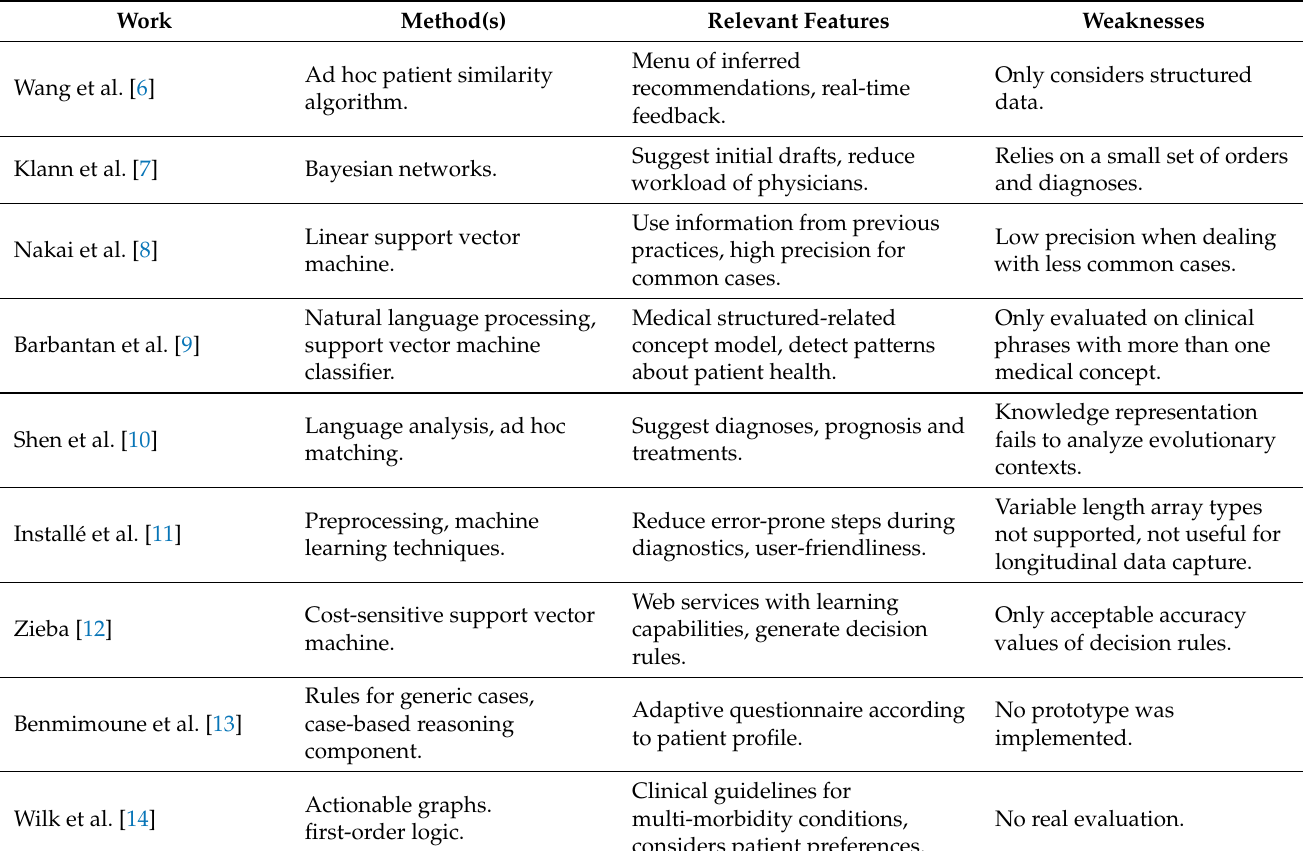
Table 1. Summary of reviewed